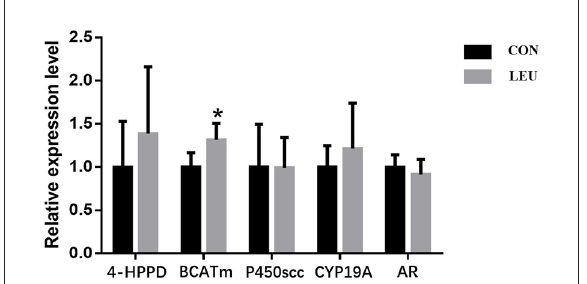
FIGURE3 Effects of dietary leucine supplementation on leucine metabolism and steroid-related gene expression in the testis of boars. CON, control group; LEU, leucine group. Values are means, with their standard errors represented by vertical bars ( n = 15), * means P < 0.05. 4-HPPD, 4-Hydroxyphenylpyruvate Dioxygenase; BCATm, branched-chain AA transaminase; P450scc, cytochrome P450 cholesterol side chain cleavage; CYP19A, aromatase; AR, androgen